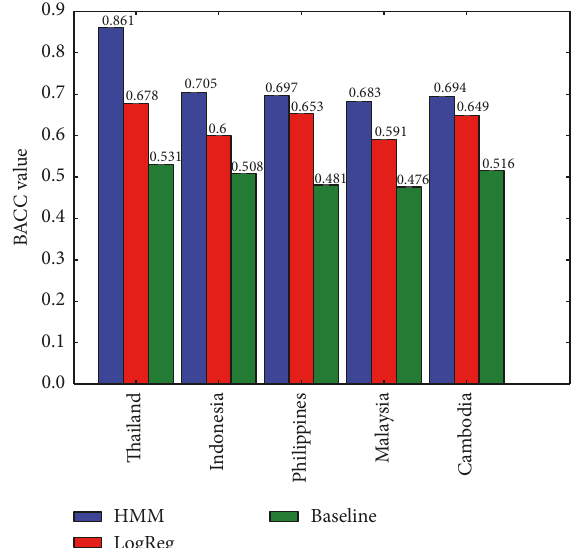
Figure 6: Comparison of our HMM based method with the LogReg model and the baseline method based on the BACC metric.